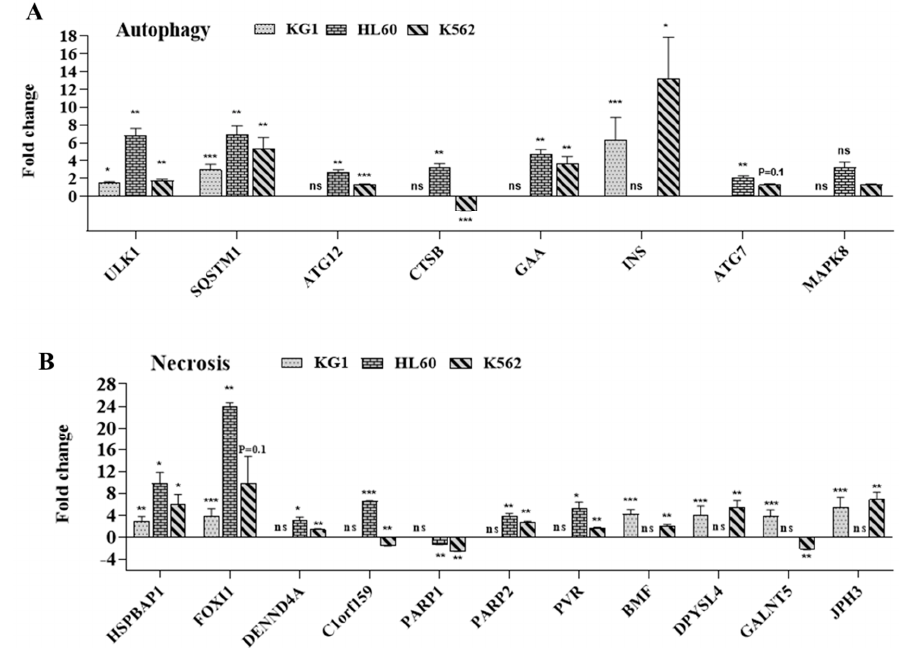
Figure 10. ( A , B ) Effect of carvacrol and thymol combination in cell death induction through non-apoptotic pathways. Relative expression of genes related to autophagy ( A ) and necrosis ( B ) cell death pathways. The levels of statistical significance as done by Anova test were set at p < 0.05 (*), p < 0.01 (**) and p < 0.001 (***). ns: no significant.